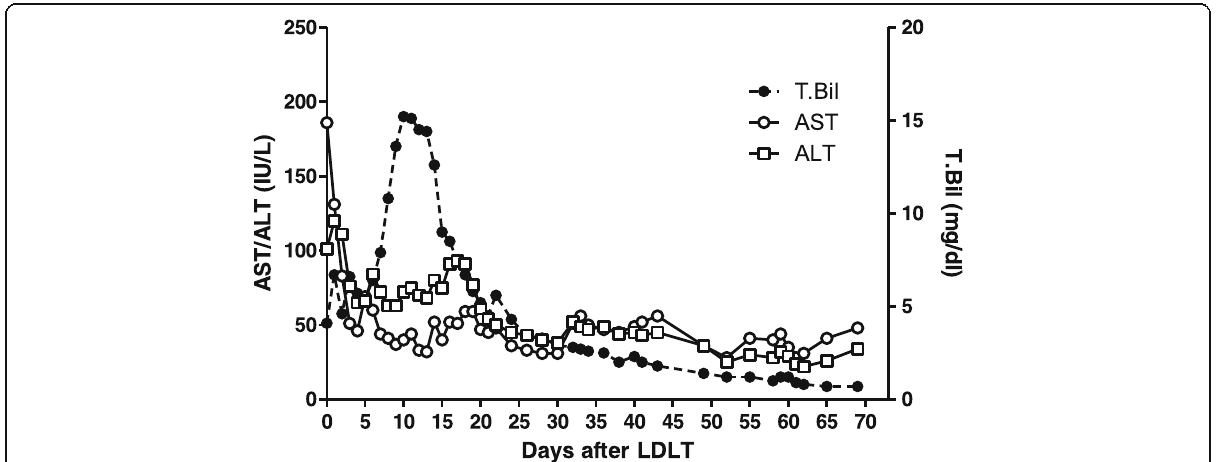
Fig. 3 Postoperative course of liver graft function. T.Bil, total bilirubin; AST, aspartate aminotransaminase; ALT, alanine